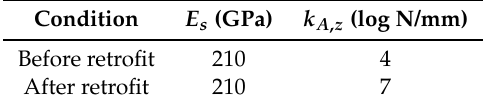
Table 2. True values of model parameters E s and k A , z used to simulate measurements.